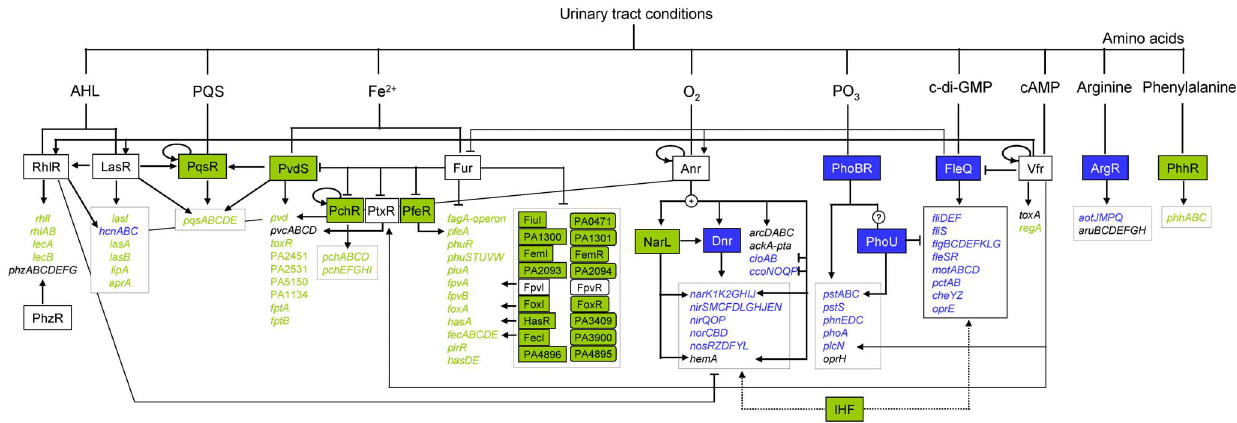
Figure 1. Regulatory network for the adaptation of P.aeruginosa to urinary tract conditions. Pairwise comparisons of the gene regulatory networks of biofilms anaerobically grown on AUM and 10-fold diluted LB were performed. For this purpose competitive transcriptome data were bioinformatically integrated into the shown regulatory network. The major regulatory signals present in the urinary tract detected by a set of global regulators controlling urinary tract related gene expression are summerized. AHL, homoserine lactone; cAMP, cyclic adenosine monophosphate; c-di- GMP, cyclic-di-guanosine monophosphate; PQS, Pseudomonas Quinolone Signal. Arrows: positive regulation, T-line: negative regulation; green: induced, blue: reduced, white: not differently expressed.